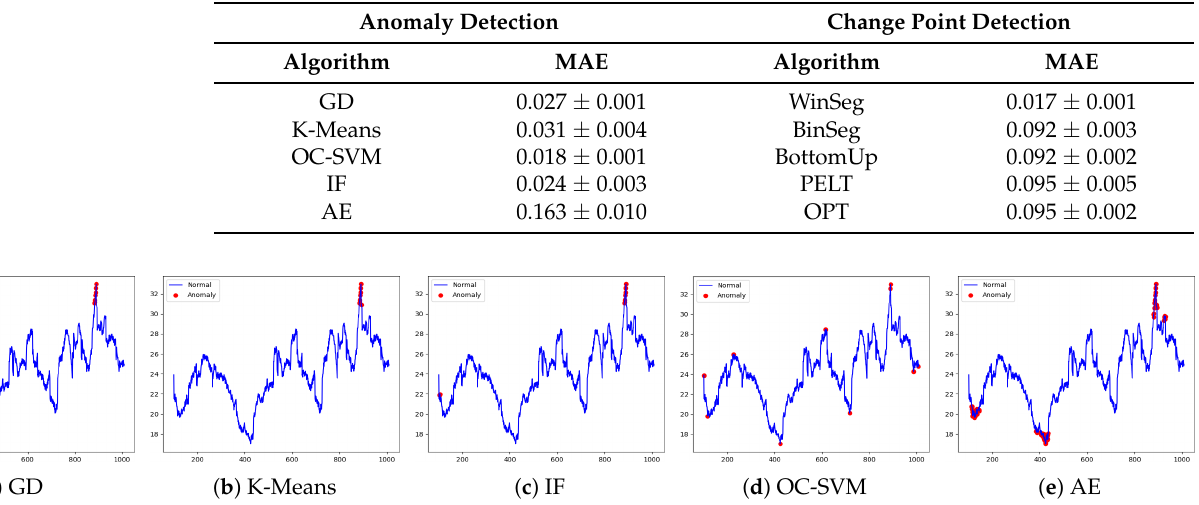
Figure 2. Anomaly Detection (Note: the line is the time series and the dot is the anomaly).